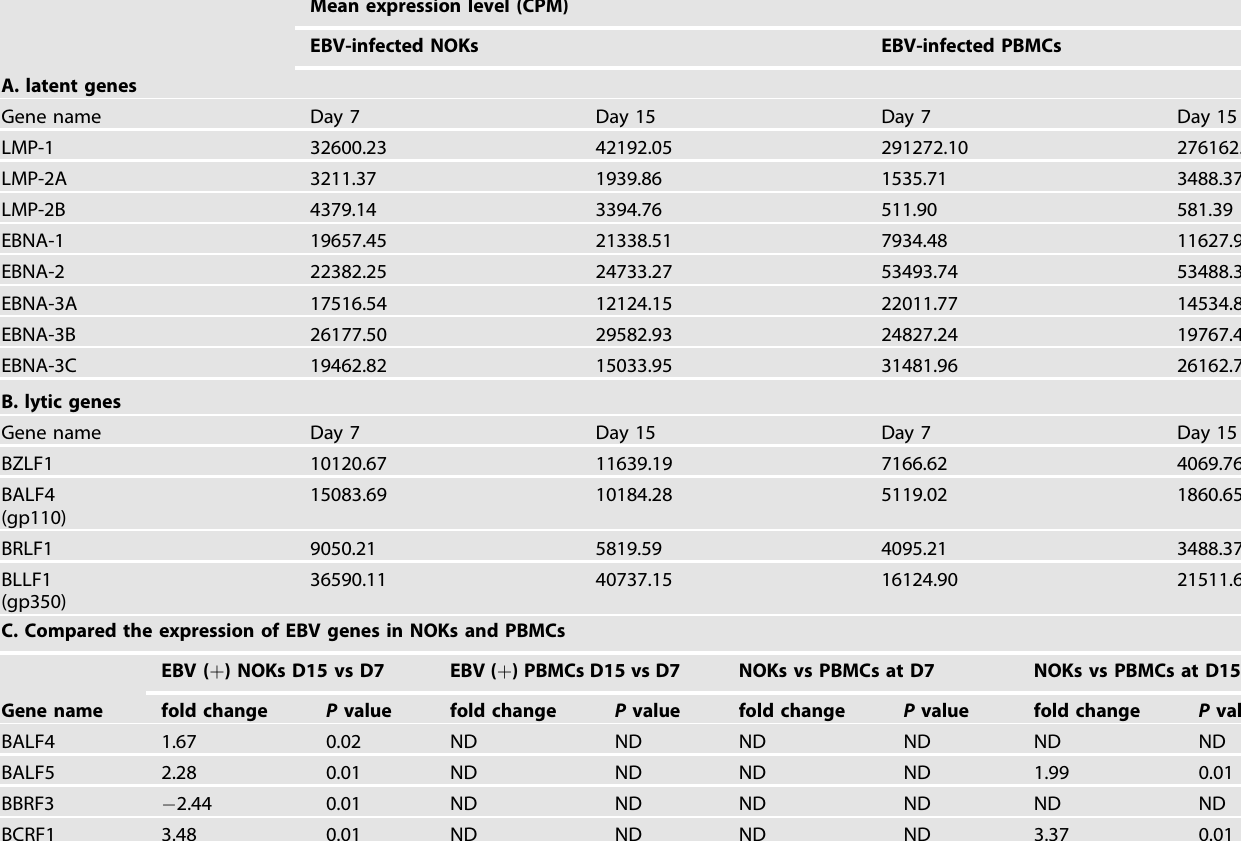
Table 1. The expression of selected EBV-encoded genes in both NOKs and PBMCs after EBV